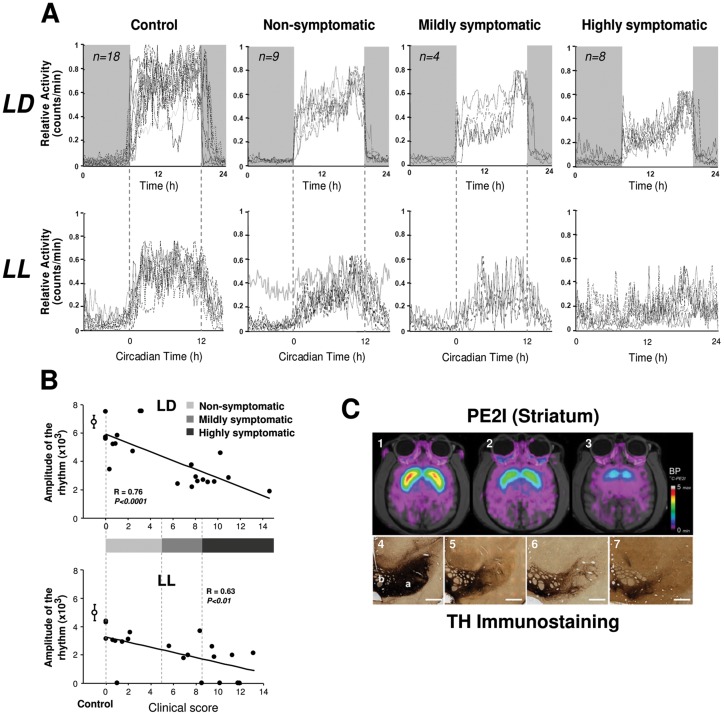
Averaged 24-activity profiles for all control and MPTP-treated monkeys with individual traces for all recordings (n = 39 assays) in LD (upper panel) and in LL (lower panel) conditions (A).Data for LD always correspond to the recording period immediately preceding LL. Control (or pre-treatment) animals show a robust daily and circadian rhythmicity with a consolidated activity during the light phase in LD and the subjective day in LL. In MPTP-treated animals, the daily rhythmicity of locomotor activity in the LD cycle is clearly evident but becomes progressively less robust in non-symptomatic, mildly symptomatic and highly symptomatic animals. When transferred to constant LL conditions, circadian rhythmicity deteriorates and highly symptomatic animals are arrhythmic with a continuous distribution of activity throughout the 24 h period. Note that the loss of rhythmicity is also recorded in one asymptomatic animal under LL (also shown in
Fig. 2B
). Relationship between the amplitude of the rhythm (χ2 periodogram) and clinical score in LD and LL (B). A complete loss of rhythmicity is mainly, but not exclusively observed for the highest clinical scores whereas some subjects with severe motor symptoms still maintained rhythmicity. Values are shown as mean ± SEM. MPTP treatment induced loss of dopamine neurons in the mesencephalon and dopaminergic depletion of the striatum (C). Examples of [11C]-PE2I scans of the basal ganglia before (C1) and after MPTP treatment showing 69% decrease in [11C]-PE2I binding potential in the striatum (C2) and 86% in a more extreme case (C3). The reduction of TH immunostaining in the mesencephalon of MPTP-treated monkeys (C5, 65%, C6, 72%, C7, >80%) compared to a control (C4). a: Substantia nigra (SN); b: Ventral tegmental area (VTA), Scale bar: 1000 µm.